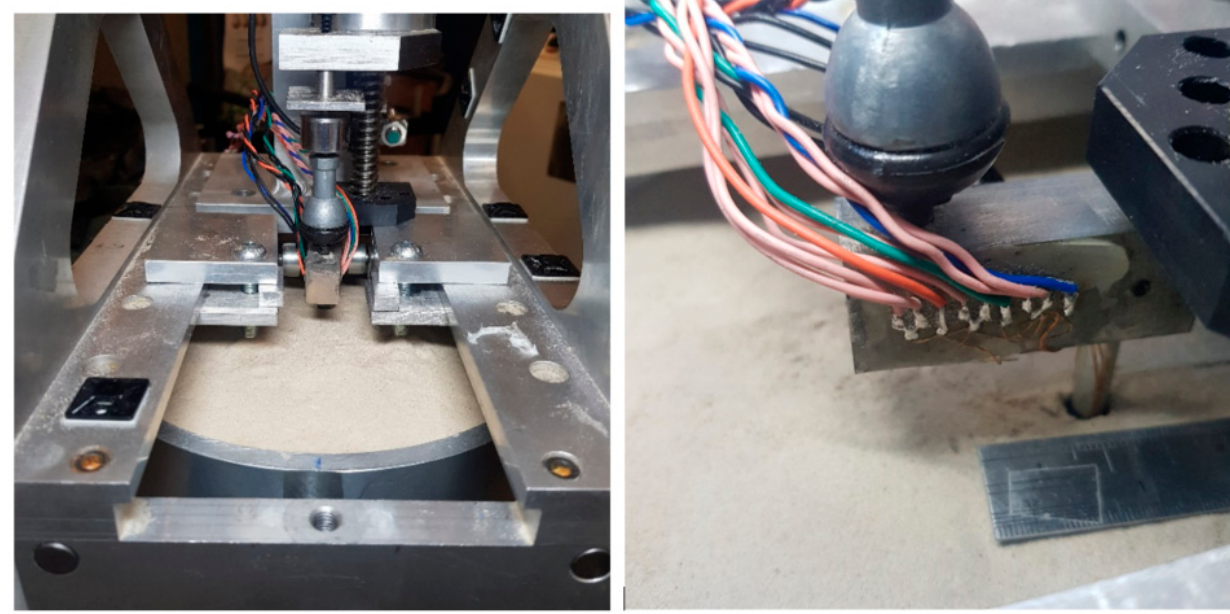
Figure 26. Example of experimental setup used in testing laterally loaded piles in the geotechnical centrifuge of the University of Manchester.